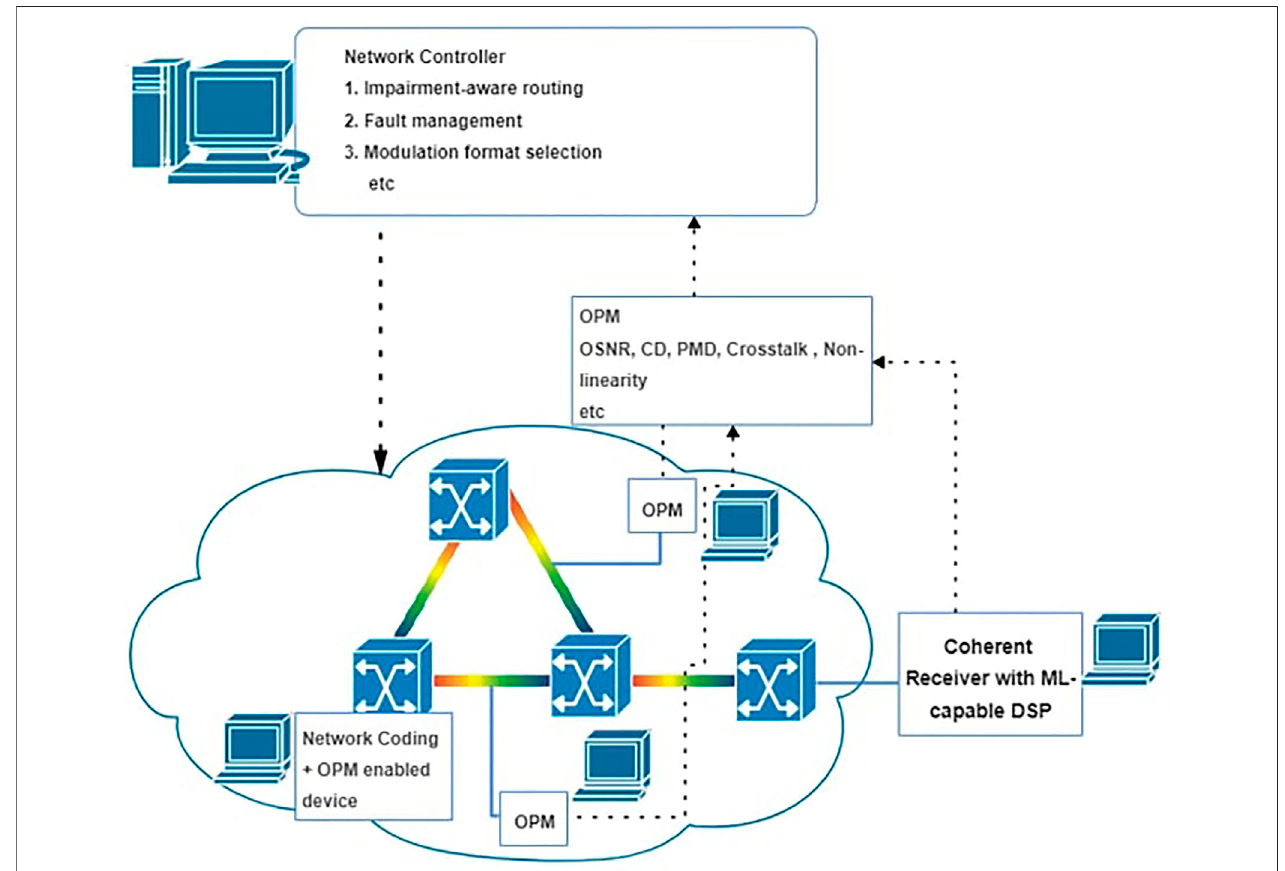
FIGURE 1 | OPM enabled intelligent network